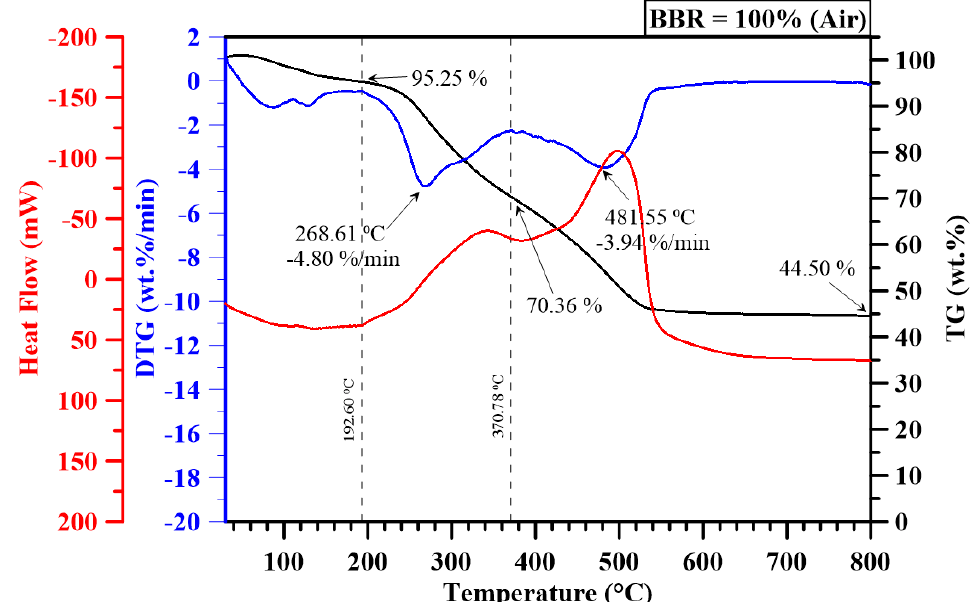
Figure 3. Thermogravimetric analysis results of sewage sludge under combustion condition.